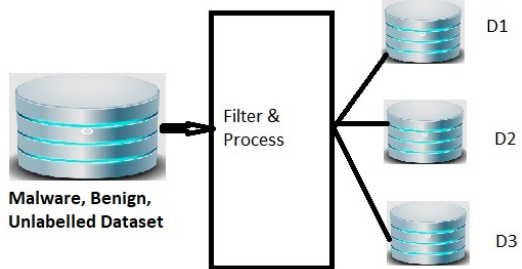
Figure 2. Derivation of D1, D2, D3 datasets from the Malware dataset scale.